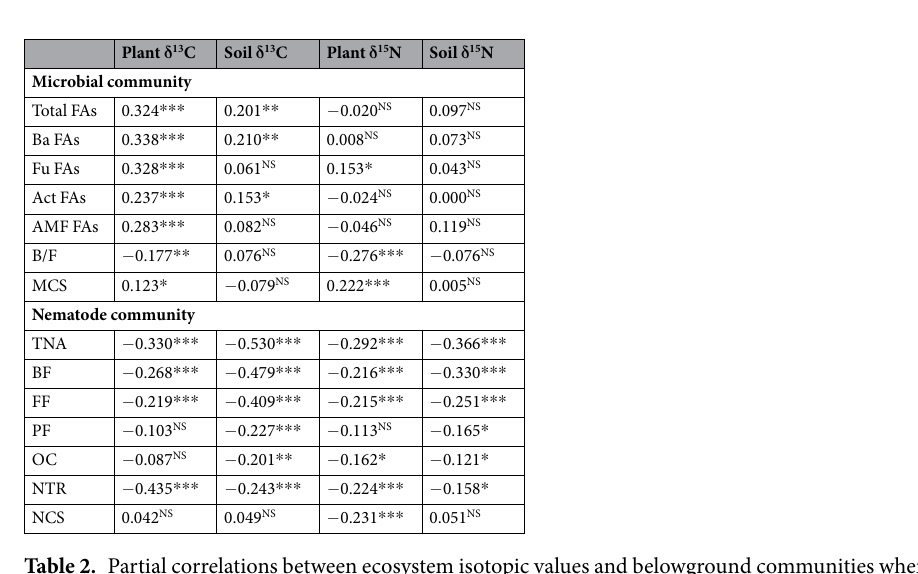
Table 2. Partial correlations between ecosystem isotopic values and belowground communities when controlling for environmental variables at the regional scale in the Mongolian grassland (n = 220). Correlation analysis is indicated by r and significance level (NS, P > 0.05; ** P < 0.01; *** P <